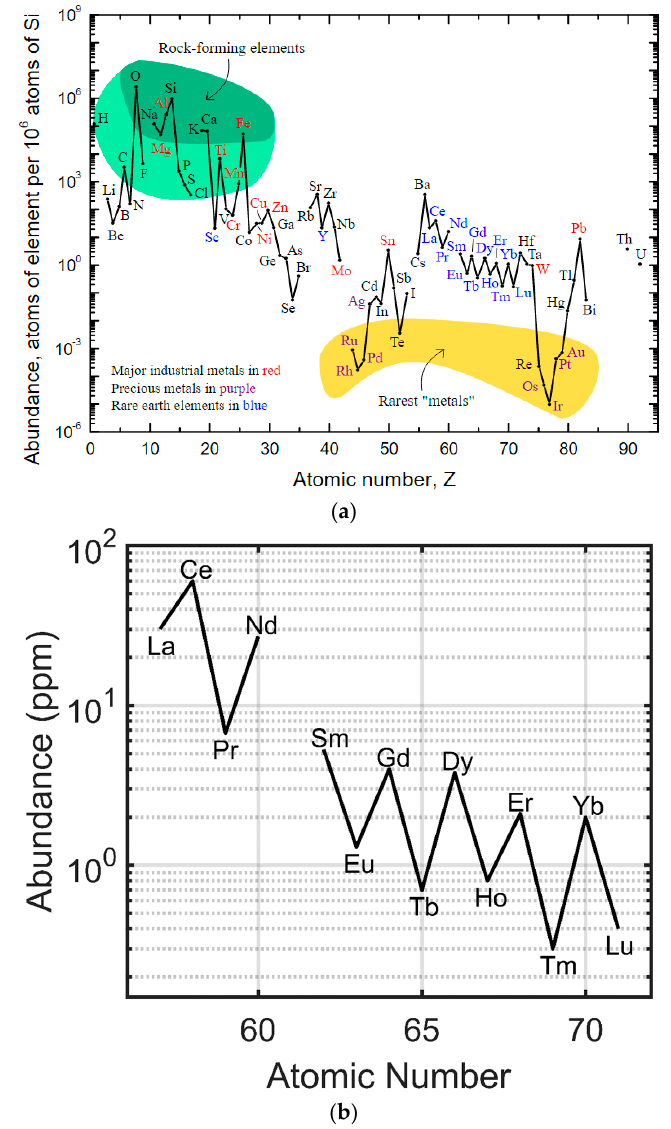
Figure 2. ( a ) Crustal abundances of the rare earth elements (REEs) relative to silicon (adapted from USGS [5]) and each other (adapted from Gupta [15]). ( b ) REEs are relatively abundant compared to palladium group metals (e.g., palladium, platinum, and rhodium).